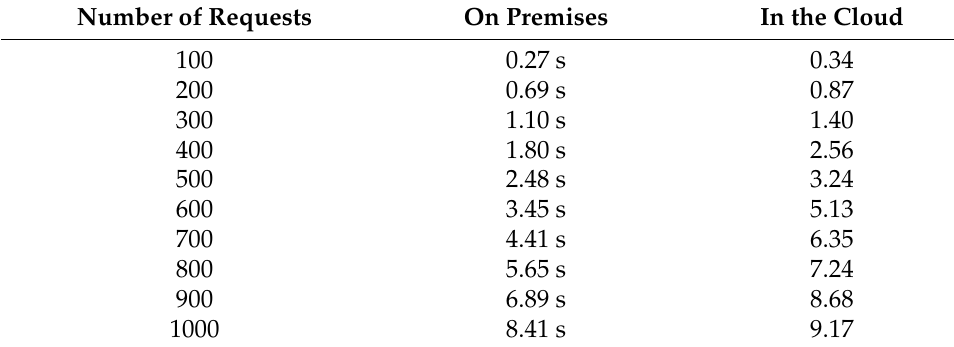
Table 5. Latency measurement.